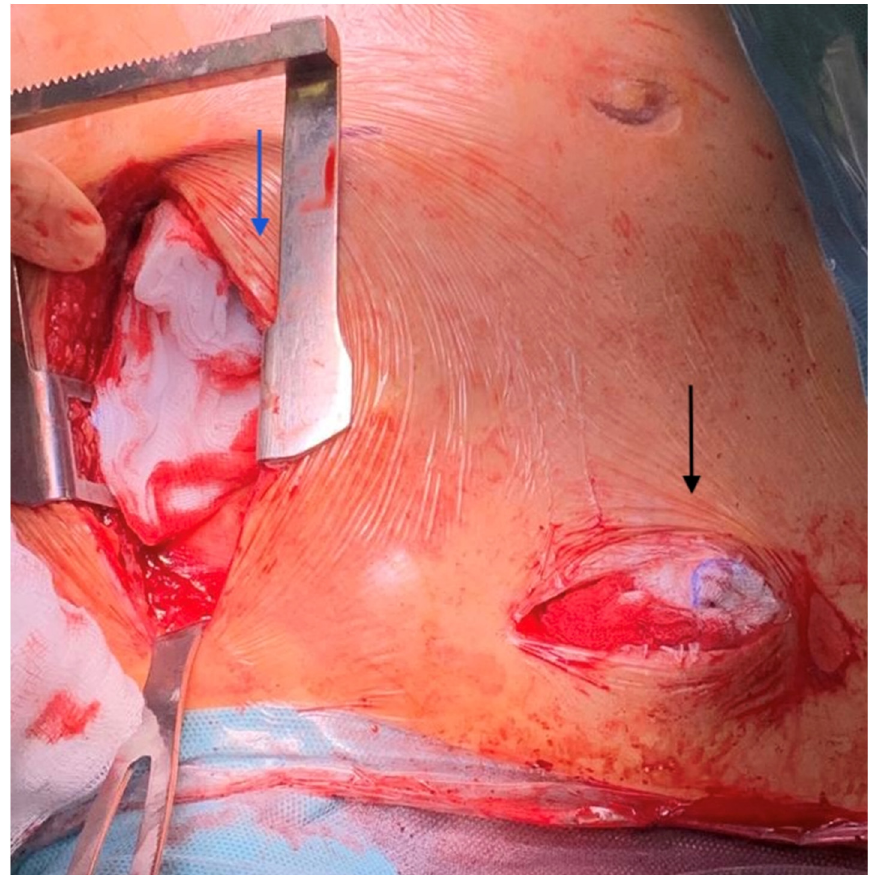
Figure 1. Attempt to approach the right axillary artery failed for severe atherosclerosis (black arrow). Conversion to trans-innominate implantation via ministernotomy (blue arrow). J-shaped incision is performed.